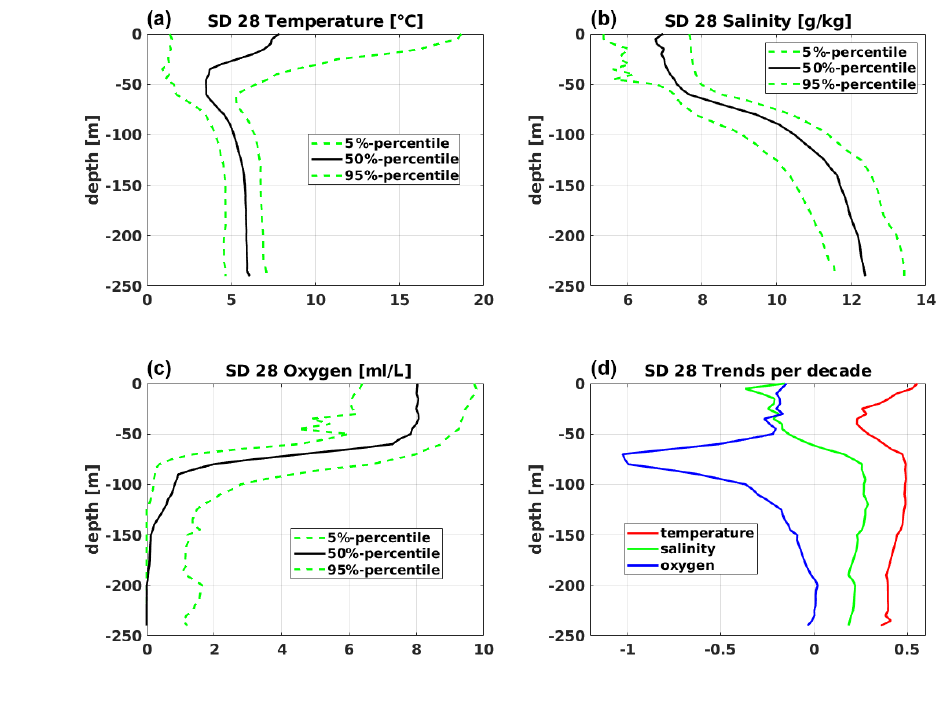
Figure 3. Percentiles (5%, 50%, and 95%) of temperature (a) , salinity (b) , and oxygen (c) profiles for Subdivision 28 (SD 28, eastern Gotland Basin) for the period 1979–2018. Trends per decade of temperature, salinity, and oxygen based on SD 28 temperature, salinity, and oxygen profiles for the period 1979–2018 (d) .